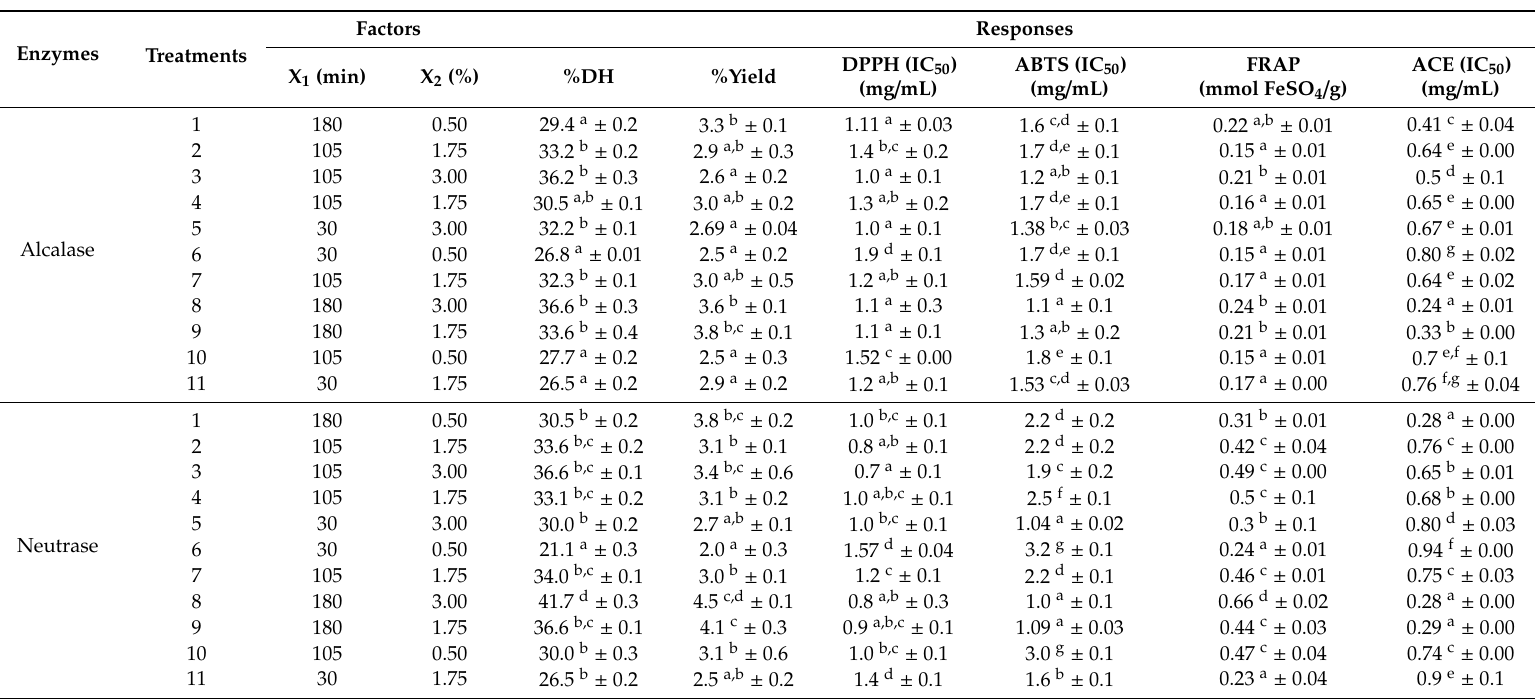
Table 1. Experimental design and all responses of degree of hydrolysis (DH), yield, DPPH radical scavenging activity, ABTS radical scavenging activity, ferric reducing antioxidant power (FRAP) assay and angiotensin-I-converting enzyme (ACE) inhibitory activity of tuna blood (TB) hydrolyzed by Alcalase, Neutrase and